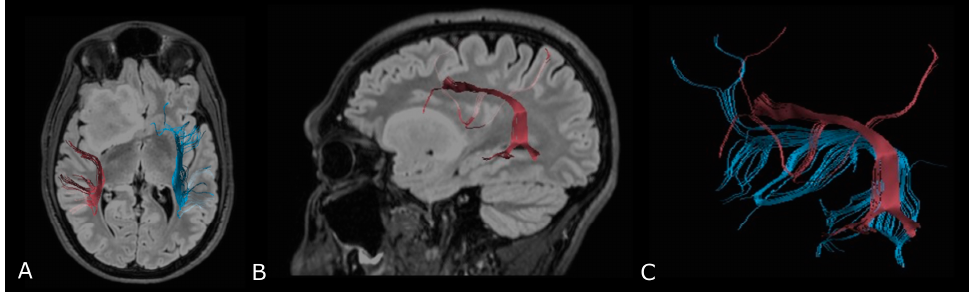
Figure 7. Tractographic reconstruction of arcuate fasciculi. DTI of the direct pathway of both arcuate fasciculi (AF) fused with anatomic axial ( A ); and sagittal ( B ) FLAIR images. The right AF on the affected side is superiorly and posteriorly displaced by an IDH-mut frontal-temporal-insular astrocytoma; ( C ) 3D rendering of both arcuate fasciculi.